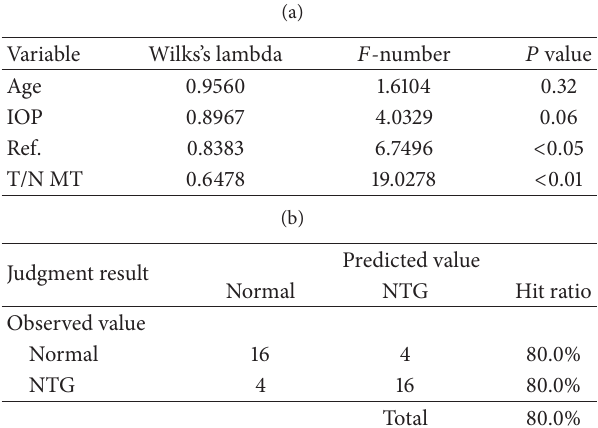
Table3:Resultsofdiscriminationanalysisforfactorsindependently contributing to